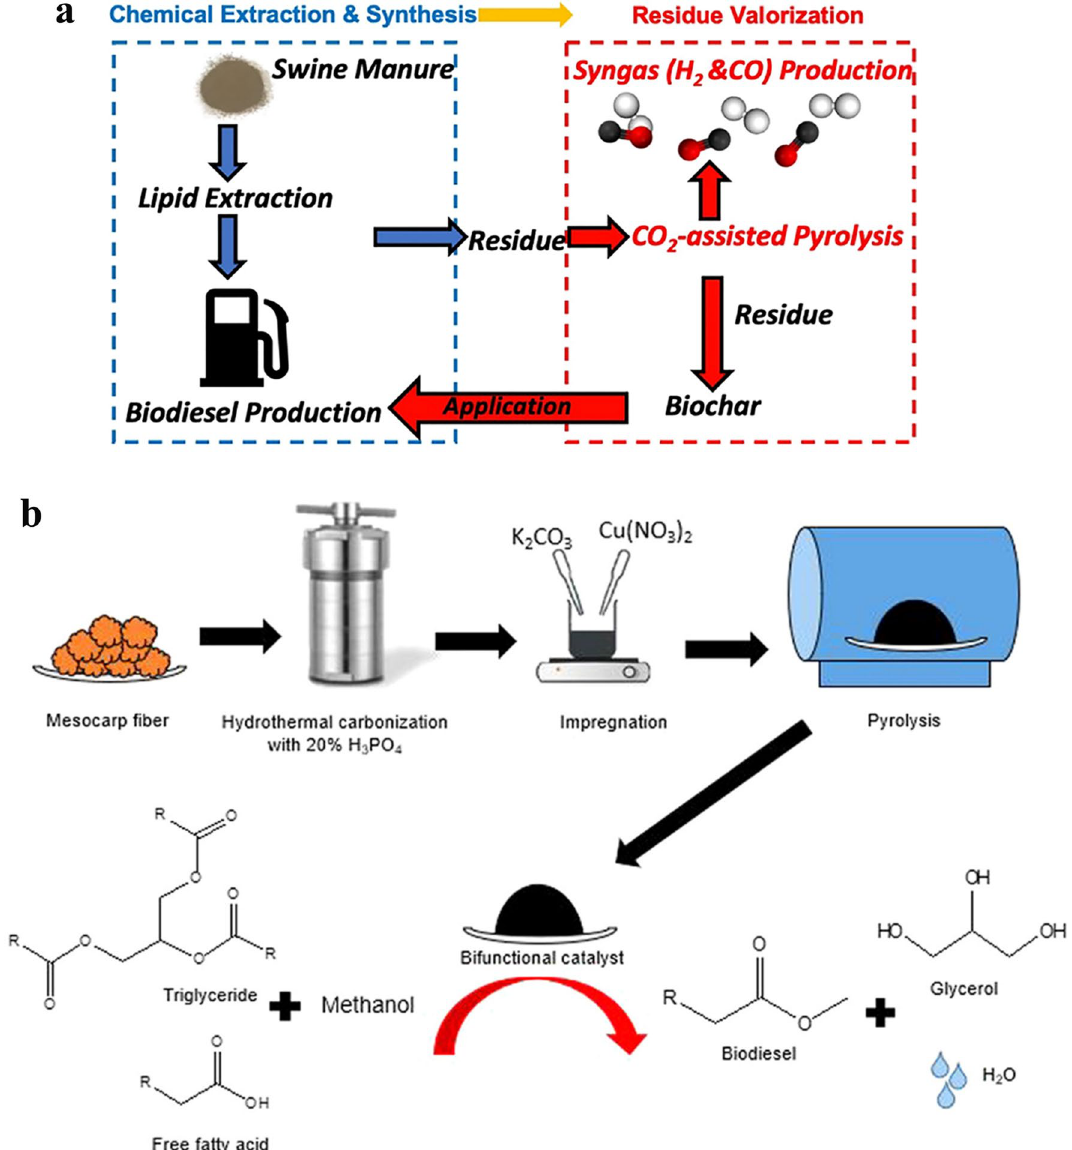
Fig. 4 Employment of biochar as heterogeneous catalysts for biofuel production. Biodiesel production through biochar-catalyzed transesterification of lipid fraction extracted from the swine manure ( a ) (Cho et al. 2021); Biodiesel production with K 2 CO 3 hydrochar as a catalyst ( b ) (Abdullah et al.